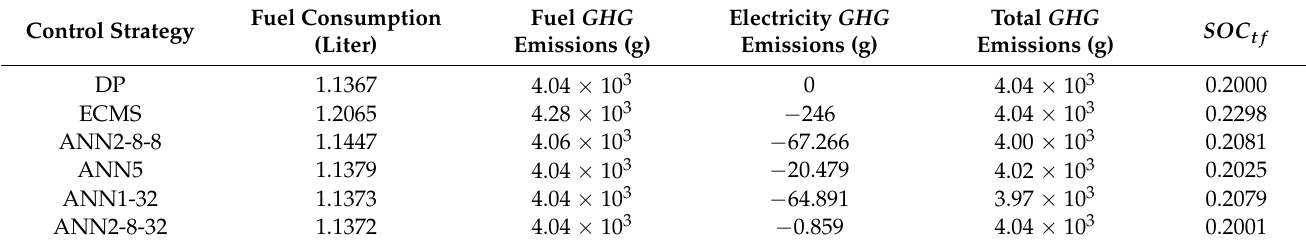
Table 7. Results comparison for NYCC-LD repeated 10